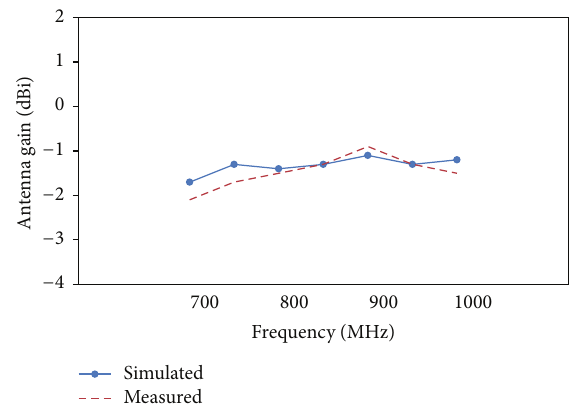
Figure 8: Simulated and measured antenna gain of the proposed antenna at V 2 port.